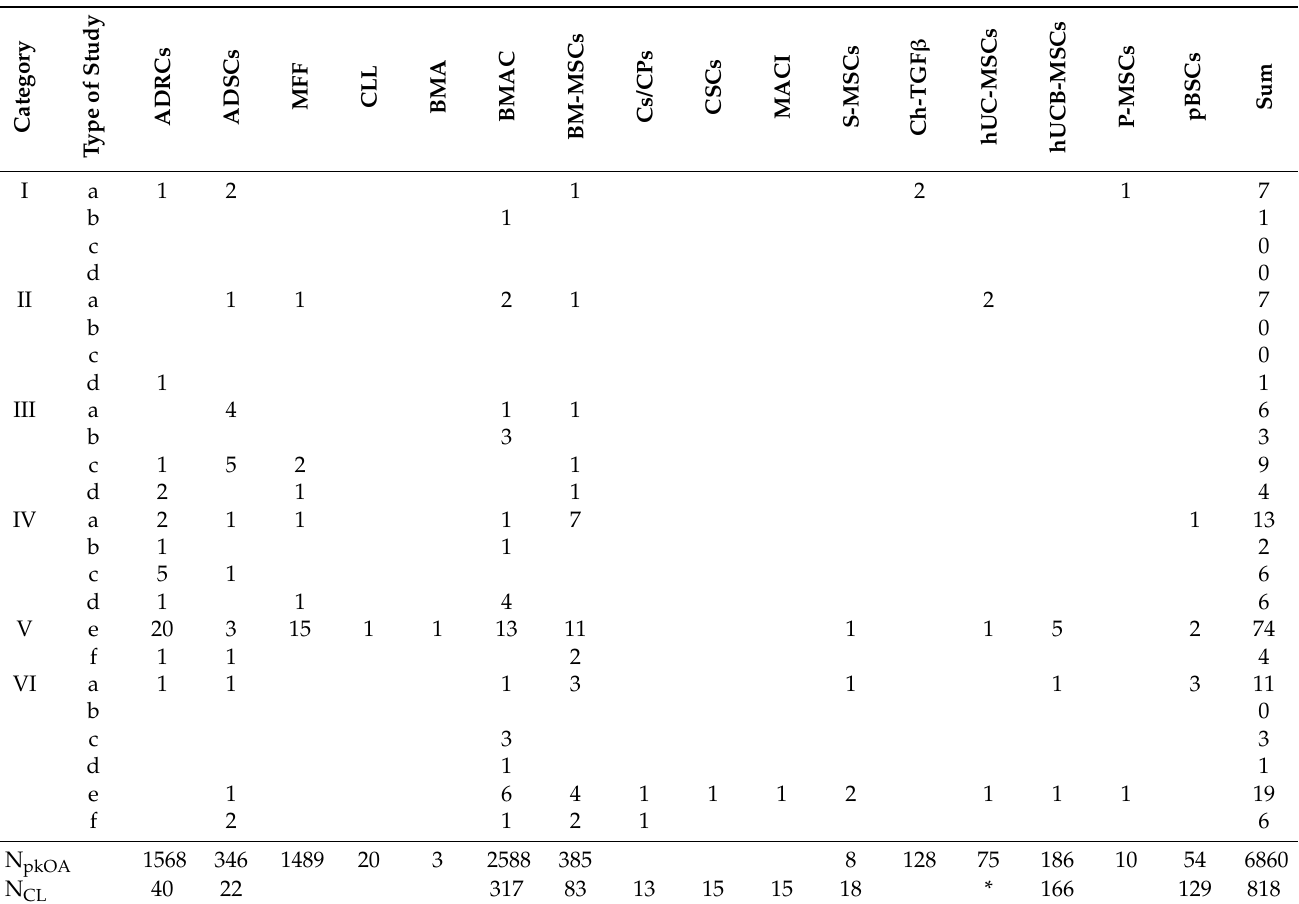
General abbreviations: N pkOA , number of patients with primary knee osteoarthritis treated in these studies; N CL , number of patients with chondral lesions treated in these studies; and *, number of patients not pro- vided. Abbreviations of cell types: ADRCs, adipose-derived regenerative cells; ADSCs, adipose-derived stem cells (obtained by culturing ADRCs); MFF, micro-fragmented fat (from liposuction); CLL; centrifuged liposuc- tion liquid; BMA, bone marrow aspirate; BMAC, bone marrow aspirate concentrate; BM-MSCs, bone-marrow- derived mesenchymal stromal cells; Cs, chondrocytes; CPs, chondrocyte precursors; CSCs, cartilage stem cells; MACI; matrix-induced autologous chondrocyte implant; S-MSCs, matrix-induced MSCs from